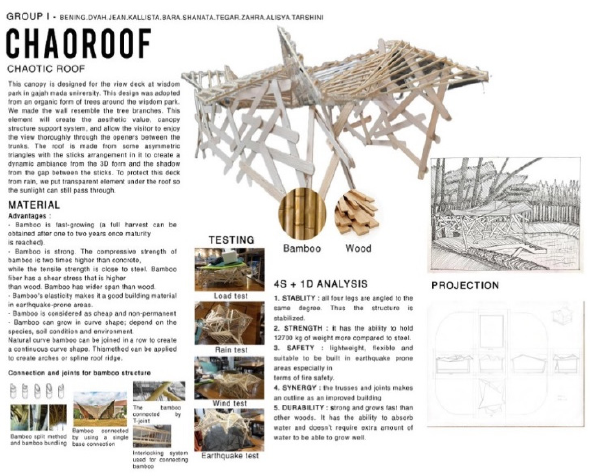
Figure A4. Deck roof.